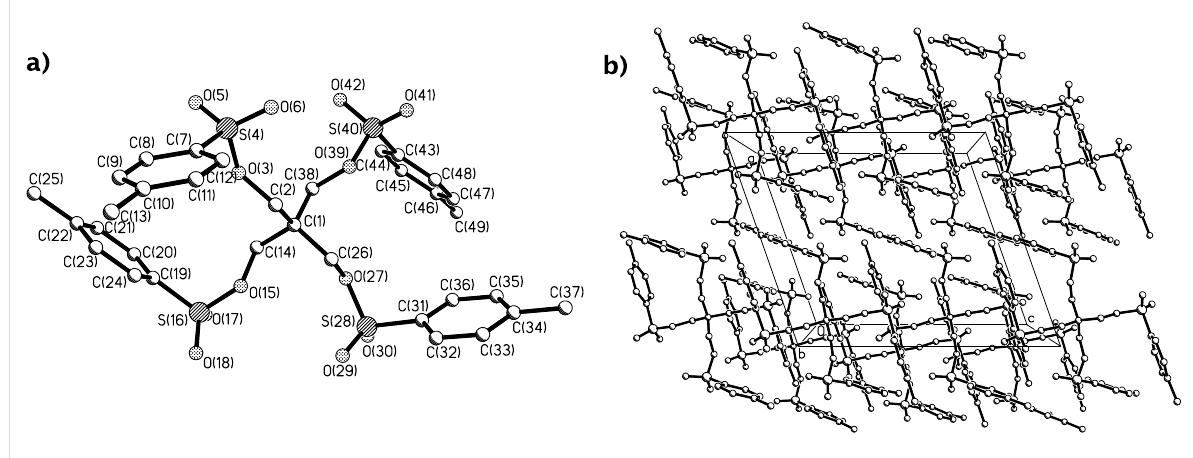
Figure 5: Molecular structure a) and packing diagram b) of the structure of penthaerythritol tetra-tosylate (TetraTos).